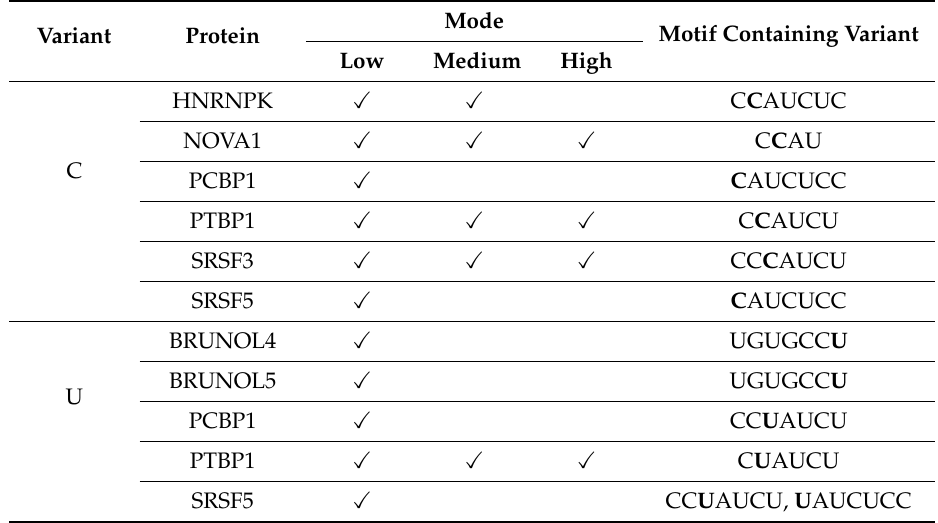
Table 3. Motif sequences of possible protein-binding sites in C- variant and U-variant found by RBPmap tool. SNPs are marked as bold.